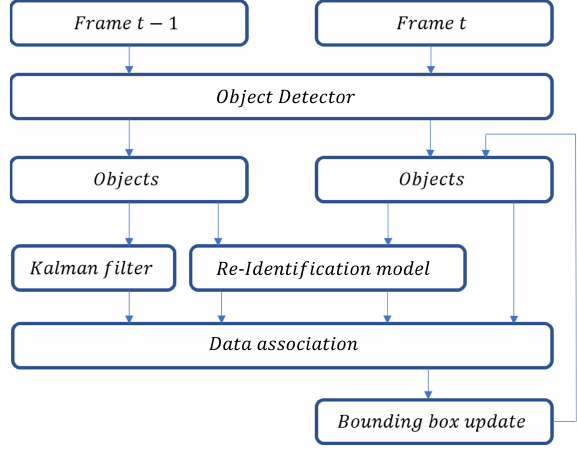
Figure 3. Flowchart of the proposed method.